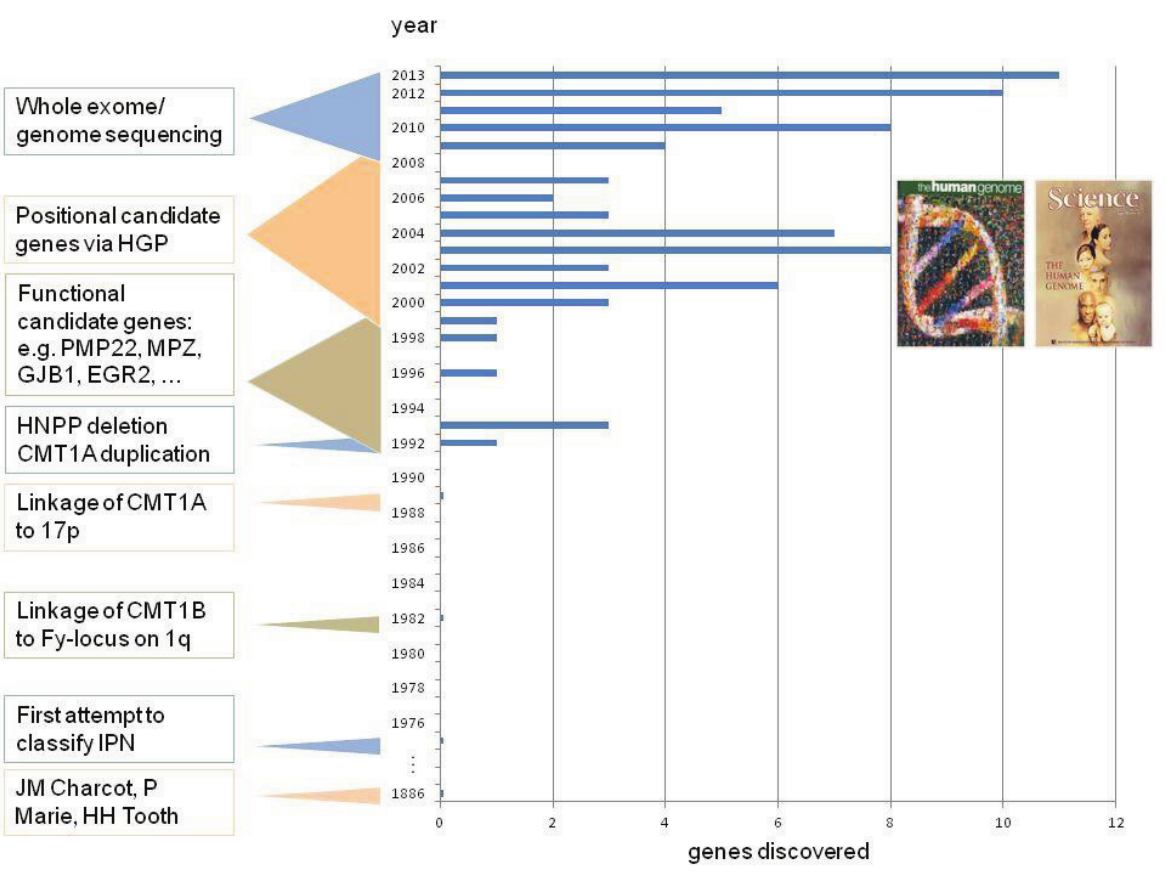
Figure 3. Historical overview of gene identification in CMT and related inherited peripheral